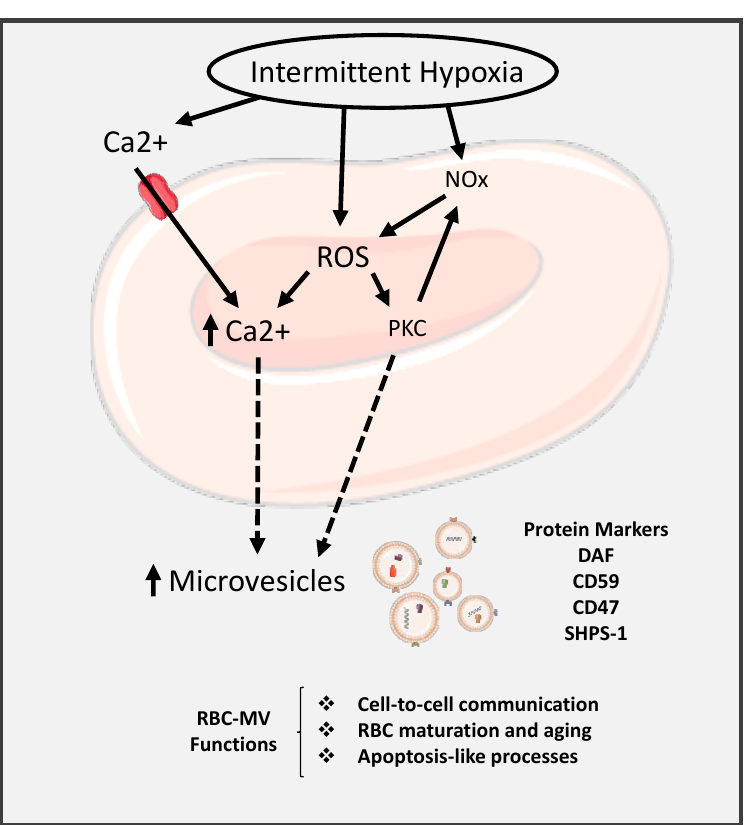
Figure 5. Diagram illustrating the effect of intermittent hypoxia on the release of microvesicles into the circulation. Arrow defined as increase or release.